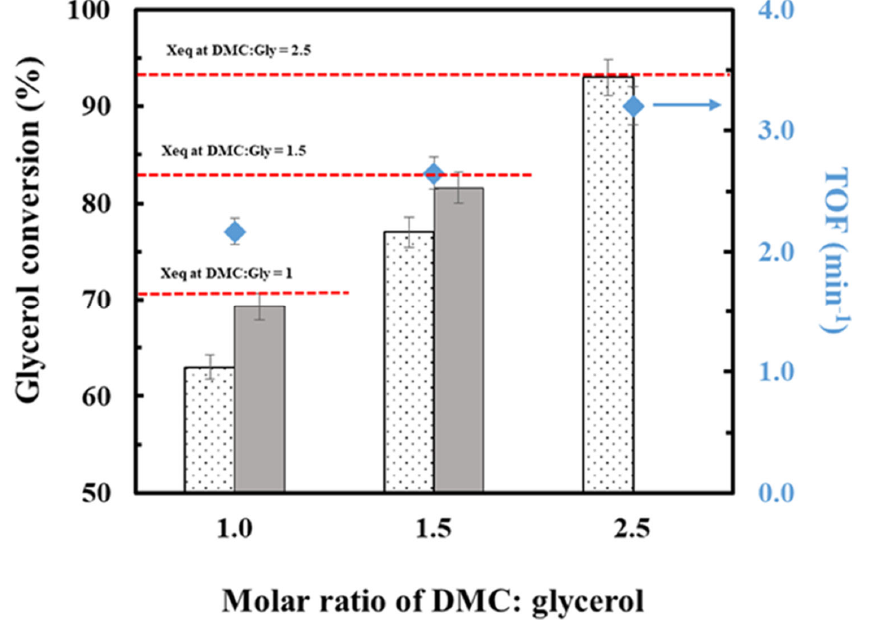
Figure 4. Effect of molar ratio of DMC: glycerol on glycerol conversion and TOF using kitchen countertop blender. Reaction condition: catalyst loading = 2.4 wt%, reaction temperature = 60 °C, blender speed = 7200 rpm, reaction time = 15 min, reaction time = 120 min.